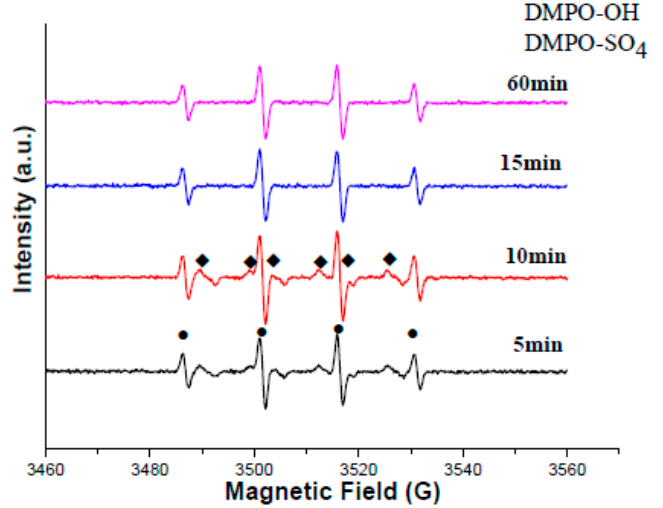
Figure 7. Electron paramagnetic resonance spectroscopy (EPR) spectra of PDS activation with EG. [AR97] 0 = 50 mg × L − 1 ; [PDS] 0 = 2 mmol × L − 1 ; [EG2] 0 = 1 g × L − 1 ; pH = 6.9.